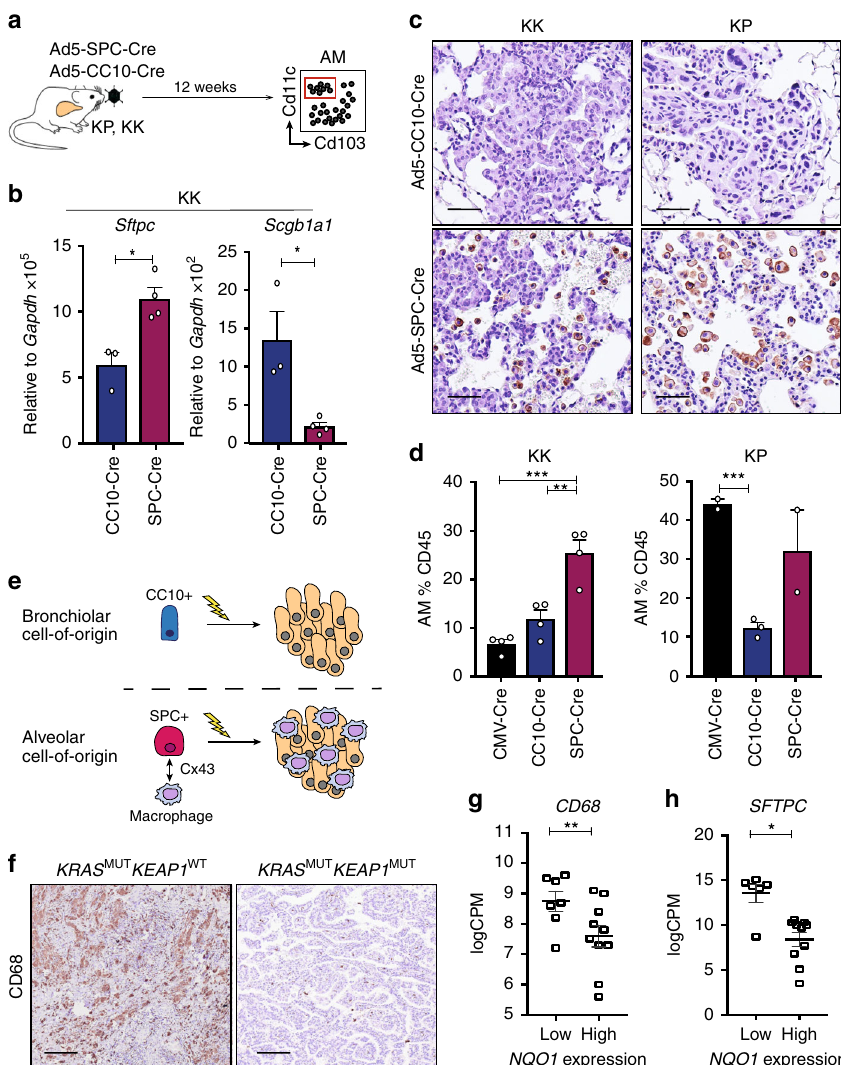
Fig. 5 Cell-of-origin determines the alveolar macrophage composition in LUAD. a Schematic of cell type-speci fi c Ad5-Cre experimental design. b Expression of Sftpc and Scgb1a1 in KK lung tumor pieces 3 months following administration of Ad5-CC10-Cre ( n = 3) or Ad5-SPC-Cre ( n = 4). Unpaired t test, Sftpc * p = 0.0168; Scgb1a1 * p = 0.0107. Mean ± SEM. c F4/80 immunostaining on lung tissue from KK and KP mice infected with Ad5-CC10-Cre